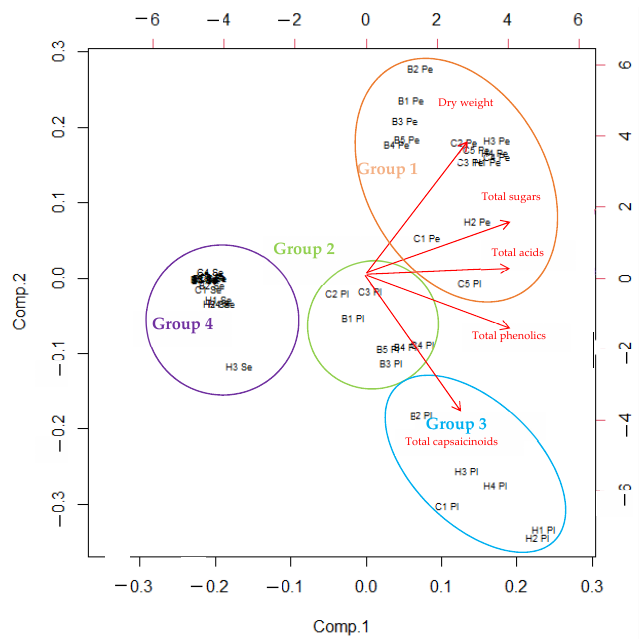
Figure 2. Biplot corresponding to PCA for all samples. Pe = pericarp; Pl = placenta; Se = seed; C = ‘Cayenne’; H = ‘Habanero Orange’; B = ‘Bishop Crown’; cultivar labels were coded 1 to 5 according to picking position within the plant (1, innermost; 5, outermost); Group 1 to 4 = Grouping of samples based on multivariate